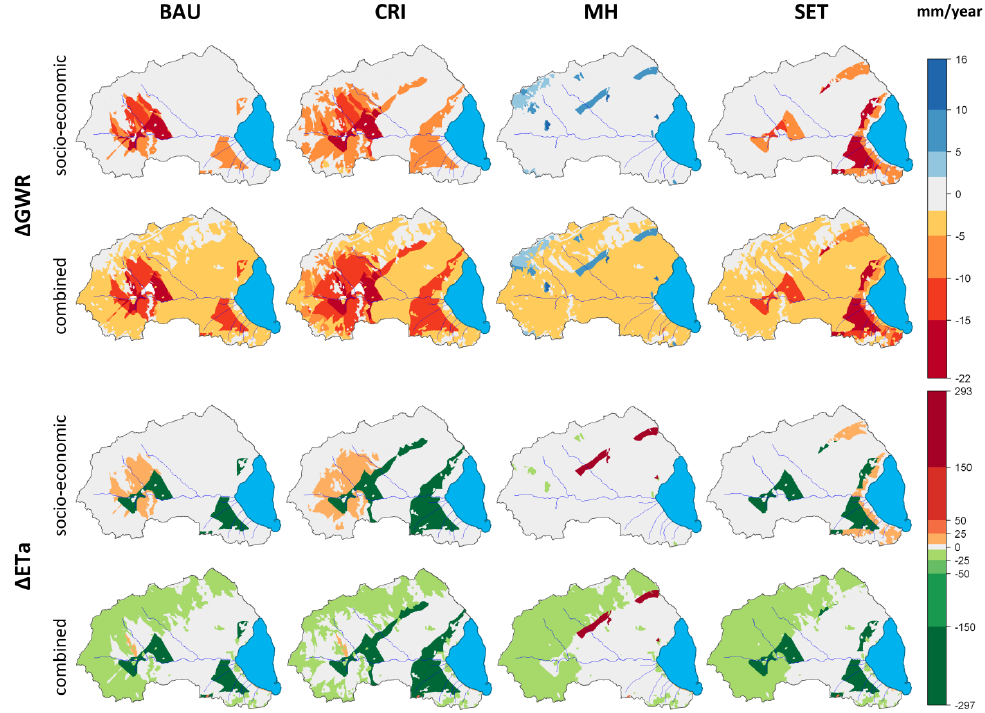
Figure 9. Maps of long-term average annual absolute spatial changes in groundwater recharge (GWR) and actual evapotranspiration (ETa) in the Mar Menor catchment showing the socio-economic impacts only as well as the combined climate and socio-economic impacts for each of the four socio-economic scenarios (BAU, CRI, MH and SET) compared to the reference